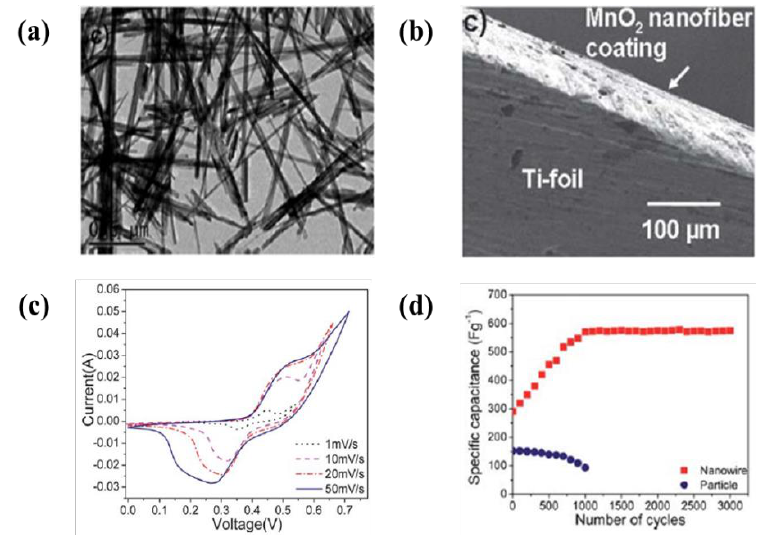
Figure 19. ( a ) TEM image of α -MnO 2 nanowires synthesized by hydrothermal method for 24 h; ( b ) SEM image of the electrophoretically deposited layer of α -MnO 2 nanowires; ( c ) Cycle performance of α -MnO 2 nanowires-based electrode in 0.1 M KOH electrolyte at different scan rates; ( d ) Specific capacitance variation with respect to the number of cycles for α -MnO 2 nanowires and particles-based